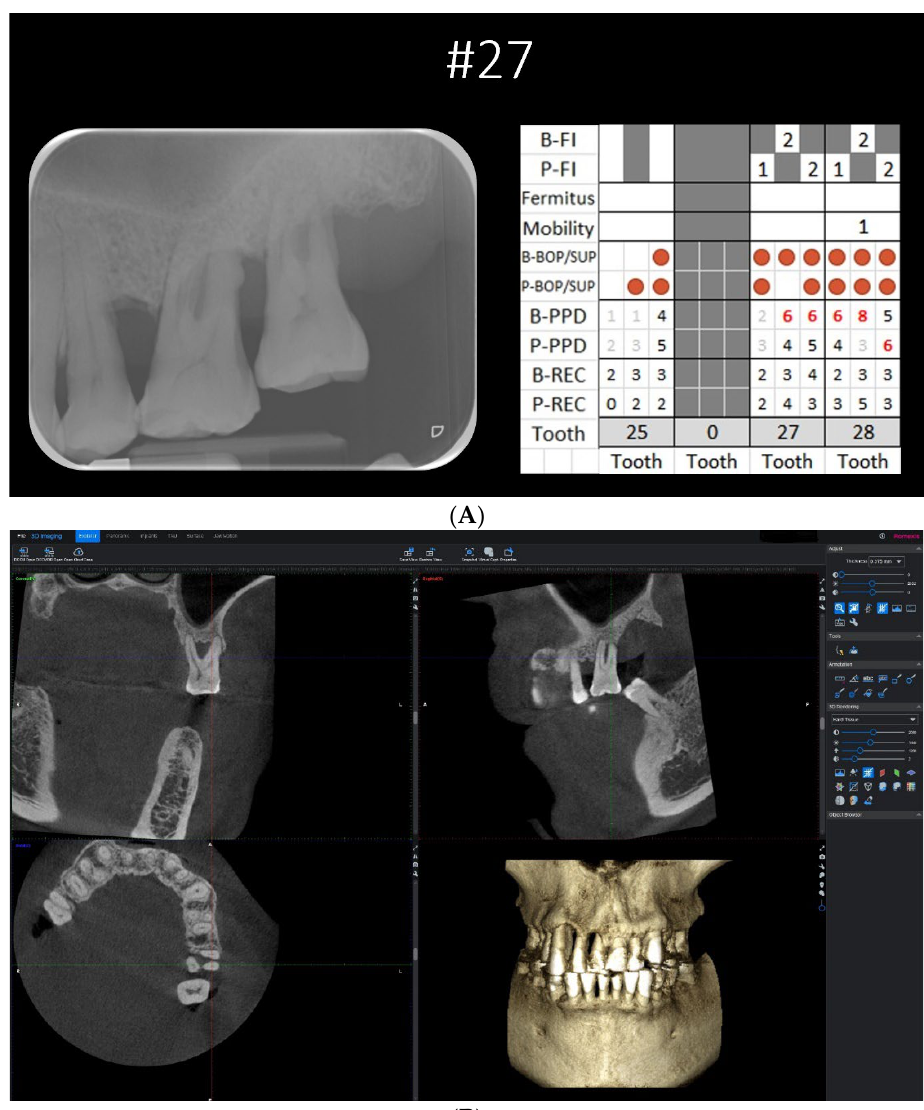
Figure 1. ( A ) Case example with a complete set of clinical periodontal record, periapical radiograph, and CBCT DICOM files as viewed on Romexis Viewer (Planmeca). ( B ) The CBCT viewer axis was first aligned along the long axis of the tooth at the sagittal section and coronal section. At the axial section, the sagittal and coronal planes were adjusted to intersect the canal orifices of the two roots bounding the concerned furcation involvement.